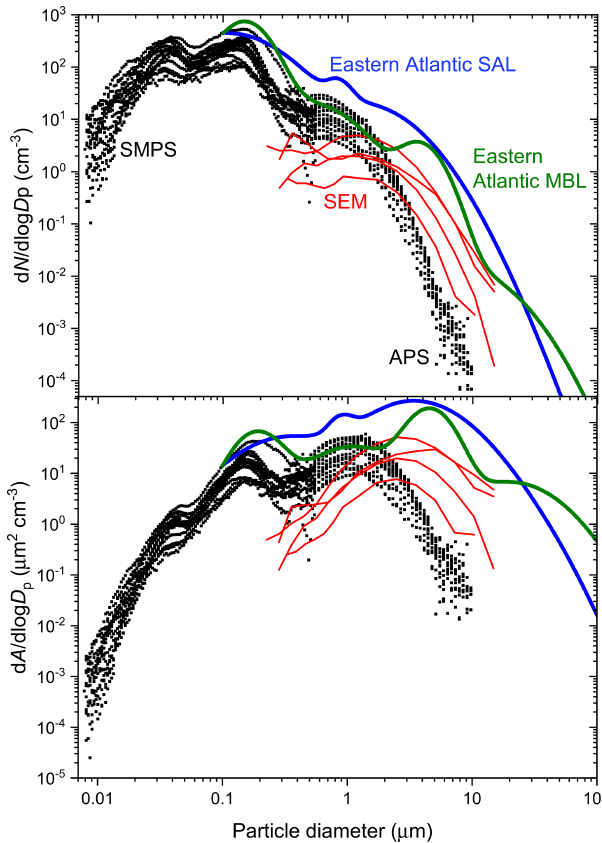
Figure 2. Compilation of size distributions of aerosol sampled over the campaign compared to data from the eastern tropical Atlantic. Data from the SMPS (scanning mobility particle sizer) and APS (aerodynamic particle sizer) spectrometer corresponding to each INP filter sample are shown (black points), alongside four distri- butions from the SEM (scanning electron microscope) analysis (red lines). The SMPS and APS size distributions have been merged to produce the volume equivalent diameter assuming parameters for mineral dust; see Methods. Size distributions for the eastern tropi- cal Atlantic are shown for both the SAL (blue line) and the MBL (green line) (Ryder et al.,